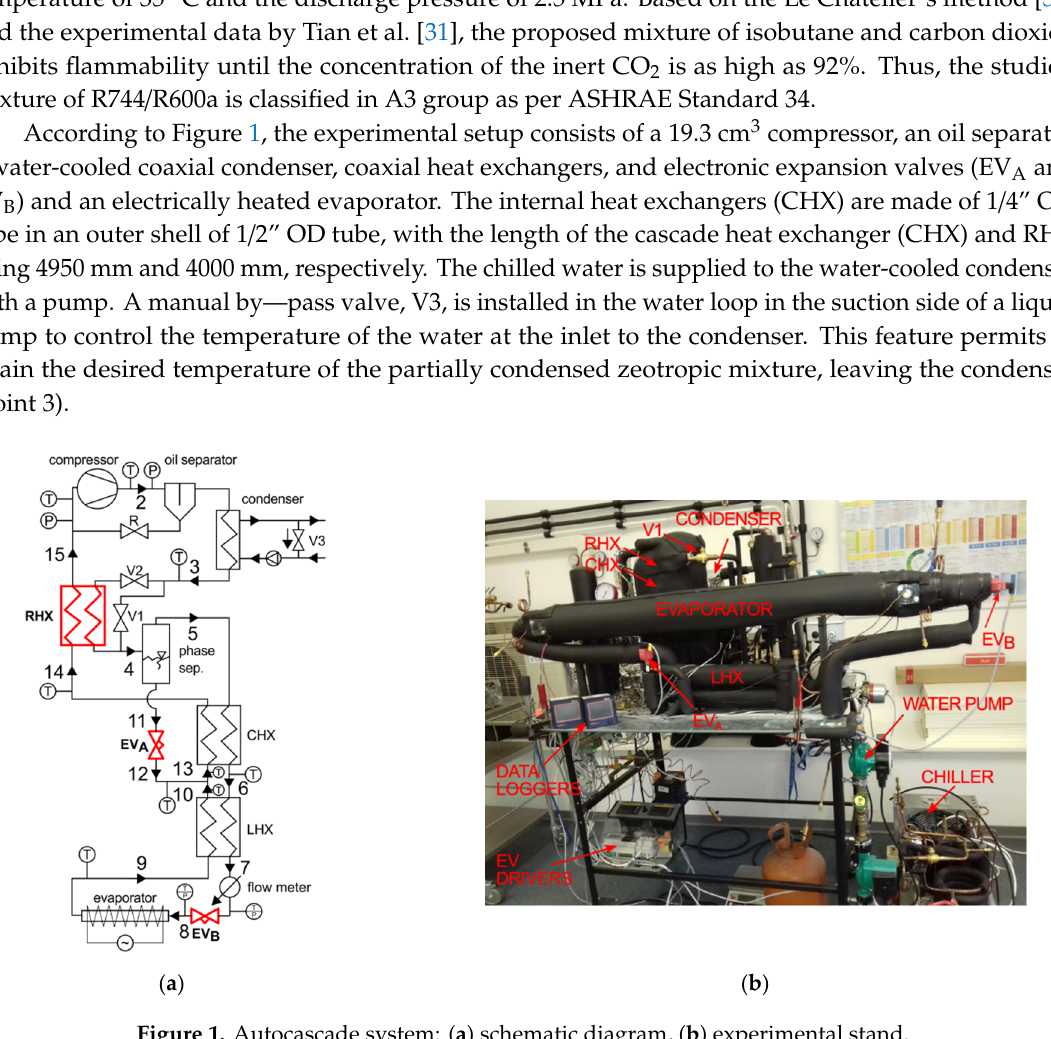
Figure 1. Autocascade system: ( a ) schematic diagram, (b ) experimental stand.